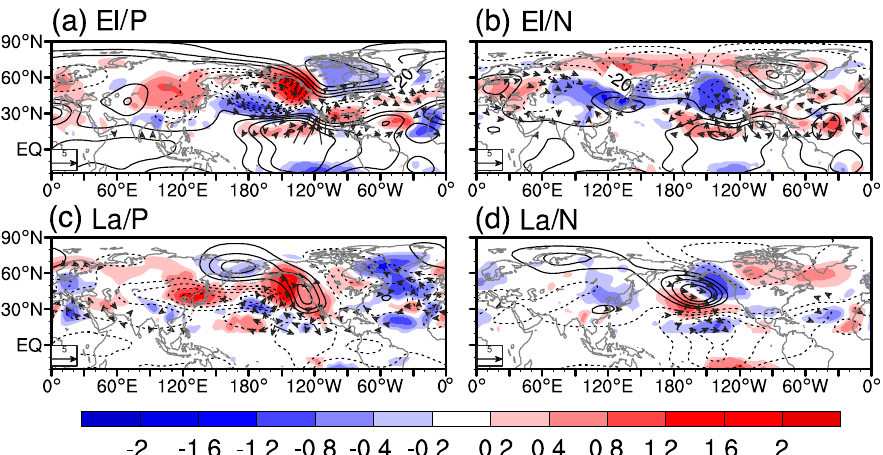
Figure 4. Composite 200-hPa height anomalies (contours; units: gpm; interval: 10) and 200-hPa wave activity flux anomalies (vectors for the horizontal component, units: m 2 s − 2 ; shadings for the vertical component, units: 10 − 2 m 2 s − 2 ) during El Niño winters when the PDO is in its ( a ) positive and ( b ) negative phases and those during La Niña winters when the PDO is in its ( c ) positive and ( d ) negative phases.